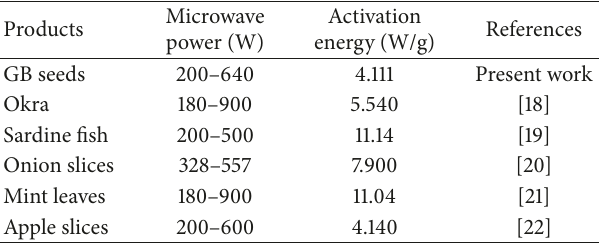
Table 2: Activation energies of GB seeds and other products under microwave